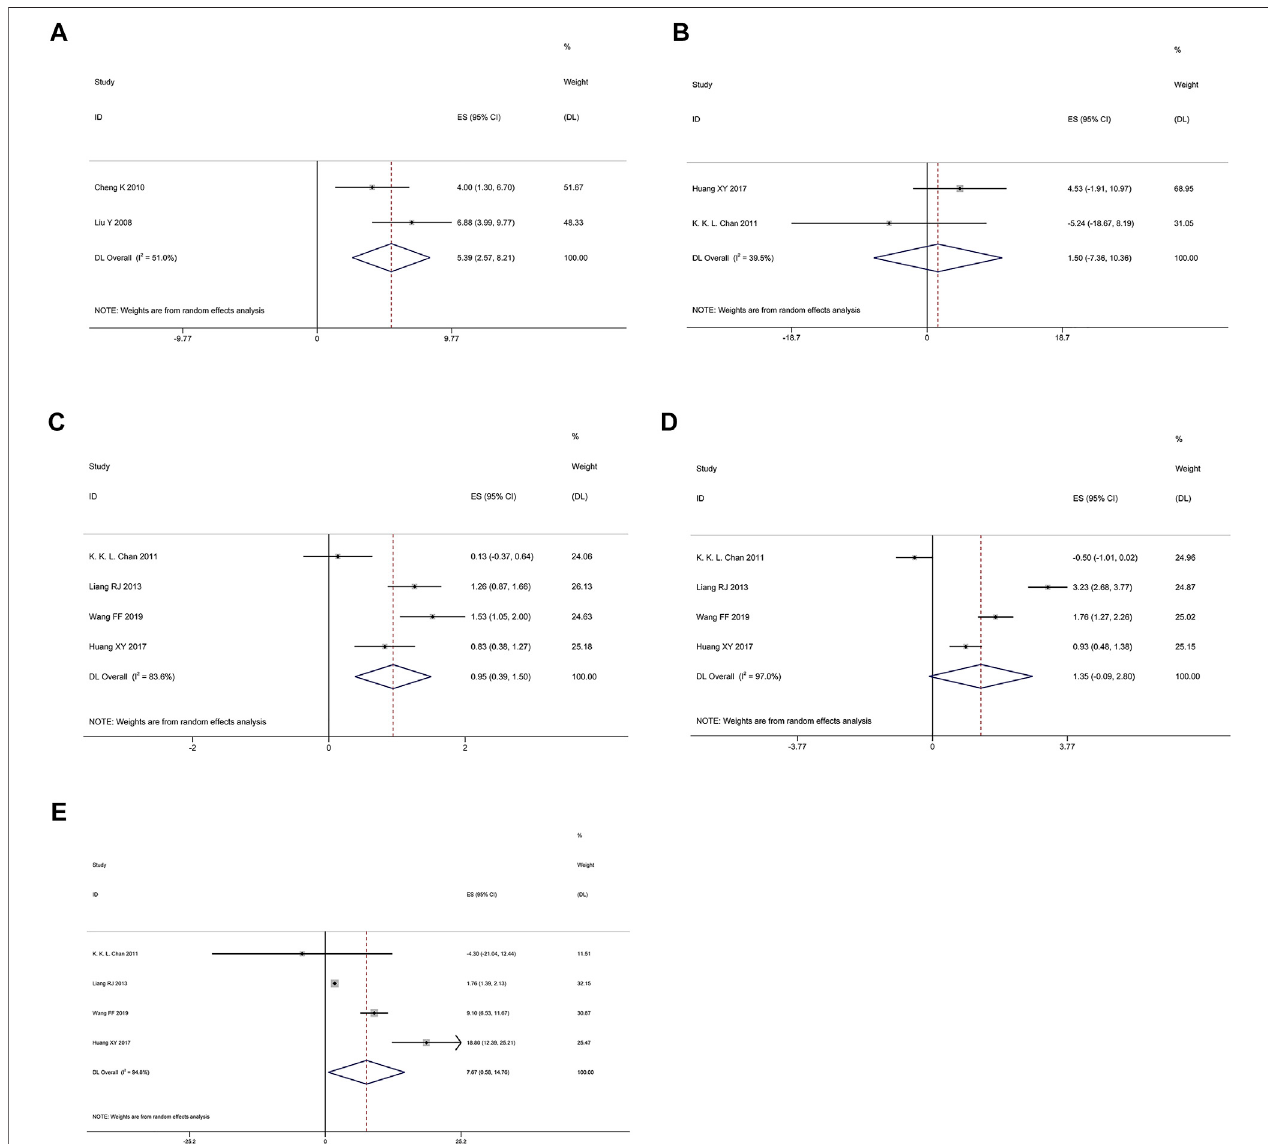
FIGURE 3 | Random effects model. (A) QOL. (B) Cognitive function. (C) Physical function. (D) Emotional function. (E) Social function.